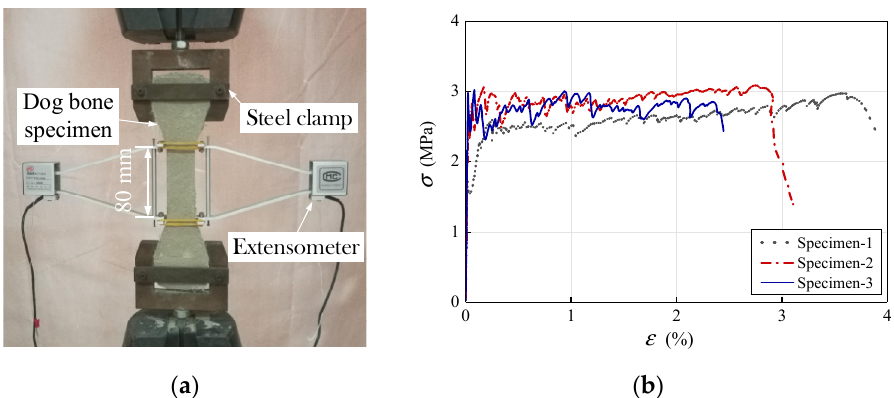
Figure 5. ( a ) Tensile tests on ECC dog bone-shaped specimens; ( b ) Tensile stress–strain curves of ECC specimens.